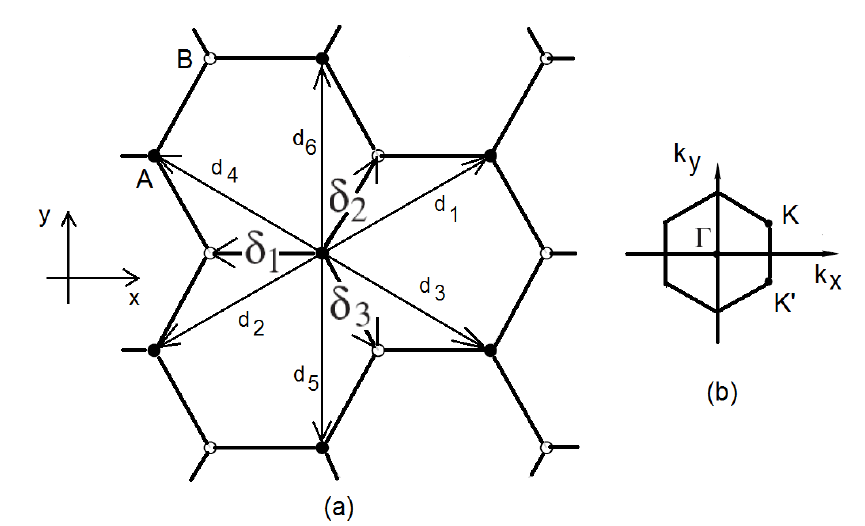
Figure 1. Honeycomb lattice ( a ) and its Brillouin zone ( b